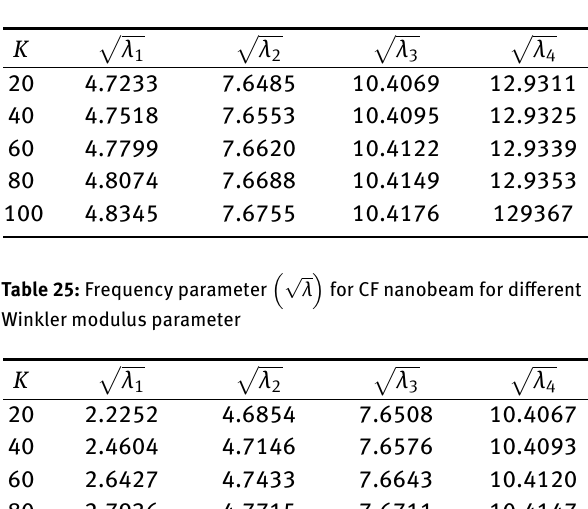
(︁ √ )︁ for SS nanobeam for different λ